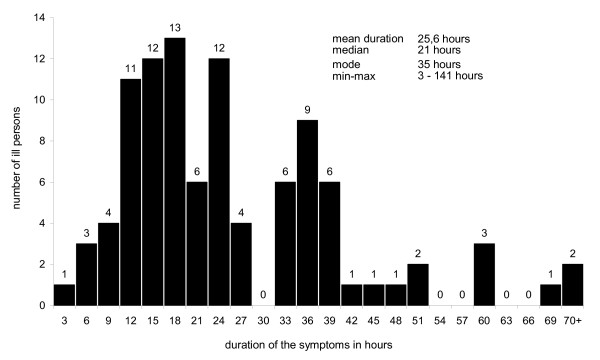
Duration of gastrointestinal symptoms.